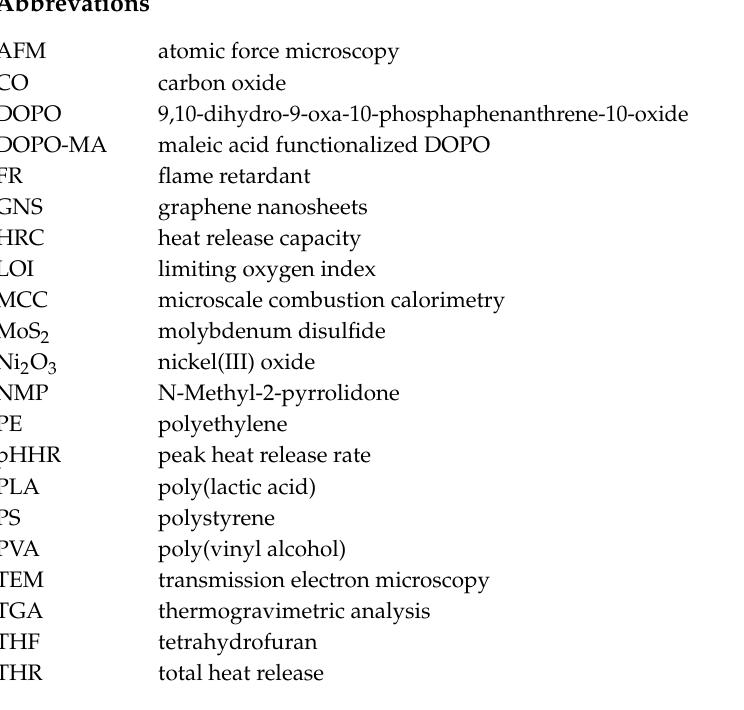
Figure S1: SEM images of (A) PE, (B) PE_MoS2_Ni2O3_DOPO_5%, (C) PLA, (D) PE_MoS2_Ni2O3_DOPO_2%, Table S1: Young’s modulus and tensile strength for composites, Figure S2: HRR curves of (A) PE_MoS2, (B) PLA_MoS2, (C) PE_DOPO, (D) PLA_DOPO, Table S2: MCC combustion data of PE and PLA composites in comparison to pristine